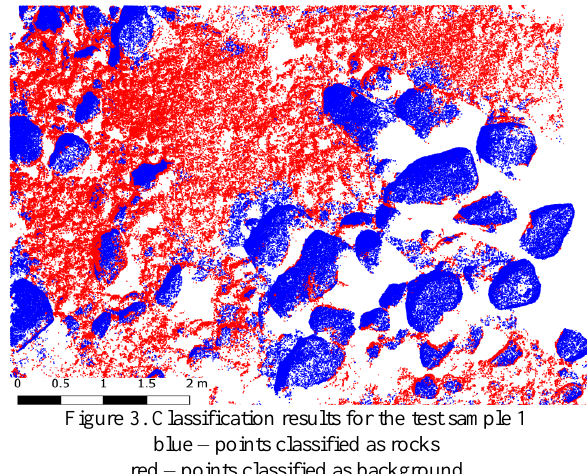
Figure 3. Classification results for the test sample 1 blue – points classified as rocks